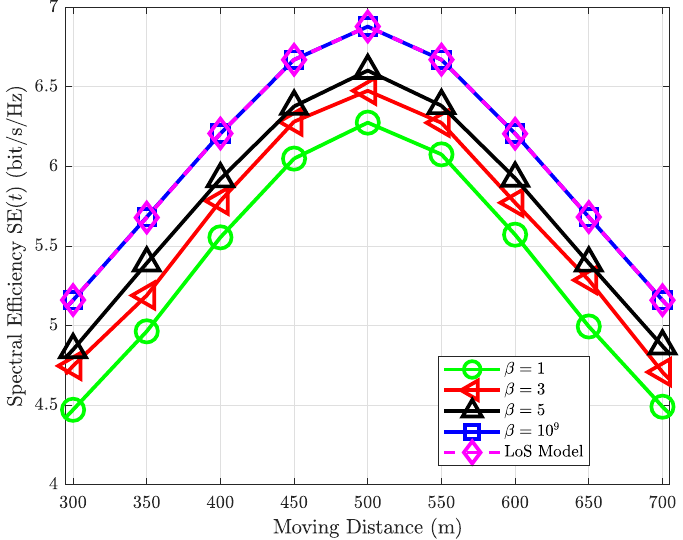
Figure 13. Spectral efficiency for different β . K =